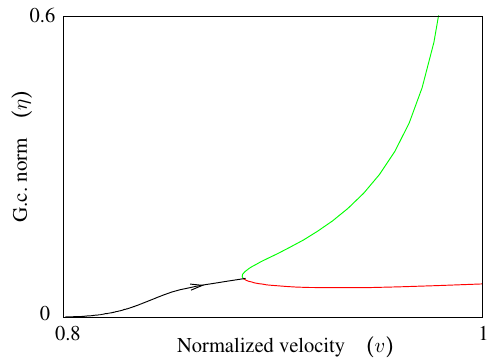
Figure 11. LCO from the optimal path (black curve with arrow indicating tracking direction) (Green means stable, red means unstable).